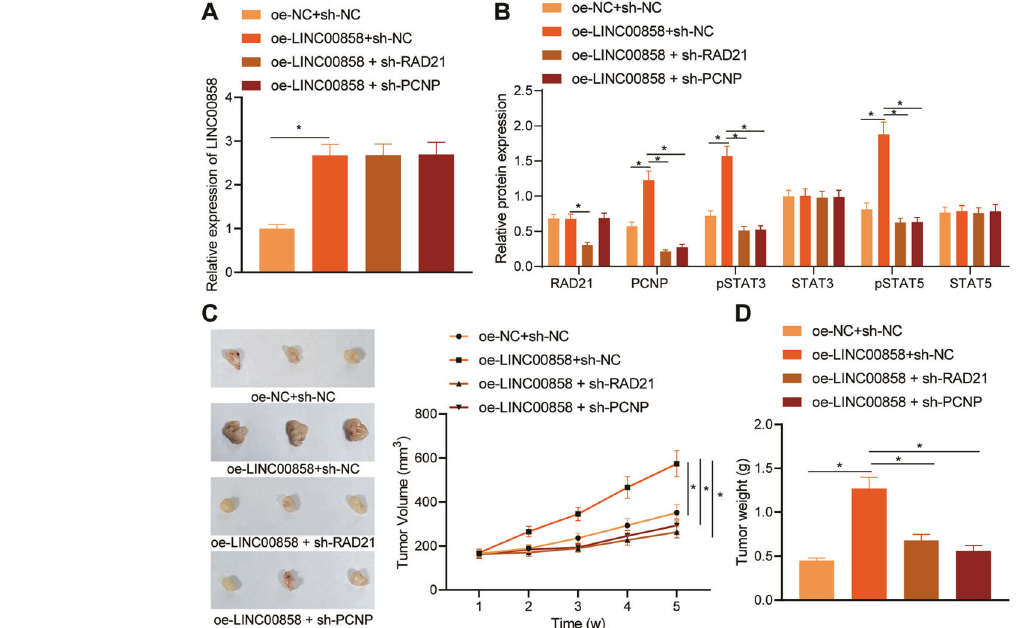
Fig. 6 LINC00858 promotes the tumorigenicity of colon cancer cells in mice by regulating the RAD21/PCNP/STAT3/5 axis. A The expression of LINC00858 in tumor tissues determined by RT-qPCR. B The expression of RAD21, PCNP, STAT3, and STAT5, and phosphorylation levels of STAT3 and STAT5 in tumor tissues detected by Western blot assay. Histogram depicting the result of gray value analysis, and the numerical value is the expression value relative to the internal parameters. C Representative images of xenografts in nude mice on day 35 of SW480 cell inoculation and the tumor volume of each group. D The tumor weight in each group of nude mice. * p < 0.05. Data from multiple groups were compared using one-way ANOVA with Tukey ’ s post hoc tests. Repeated measures ANOVA with Bonferroni ’ s post hoc test was used to compare the data obtained at different time points. n =